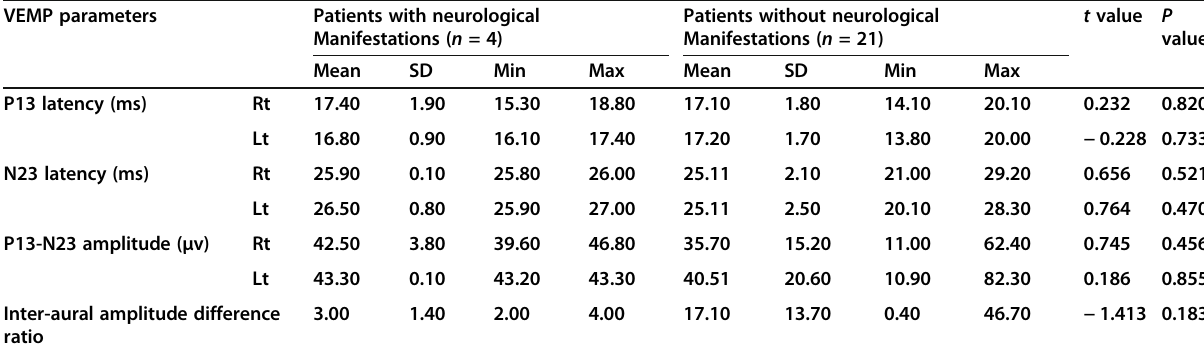
Table 7 Comparison between BD patients with and without neurological manifestations regarding VEMP results VEMP parameters Patients with neurological Patients without neurological Manifestations ( n = 4) Manifestations ( n = 21)